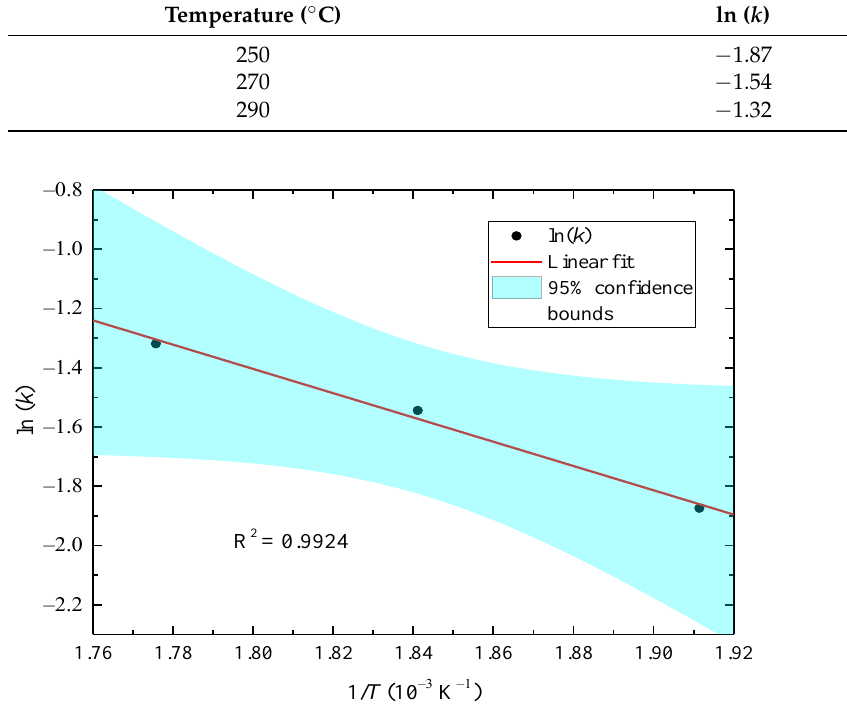
Figure 5. Determination of the apparent activation energy based on the Arrhenius-type plot.